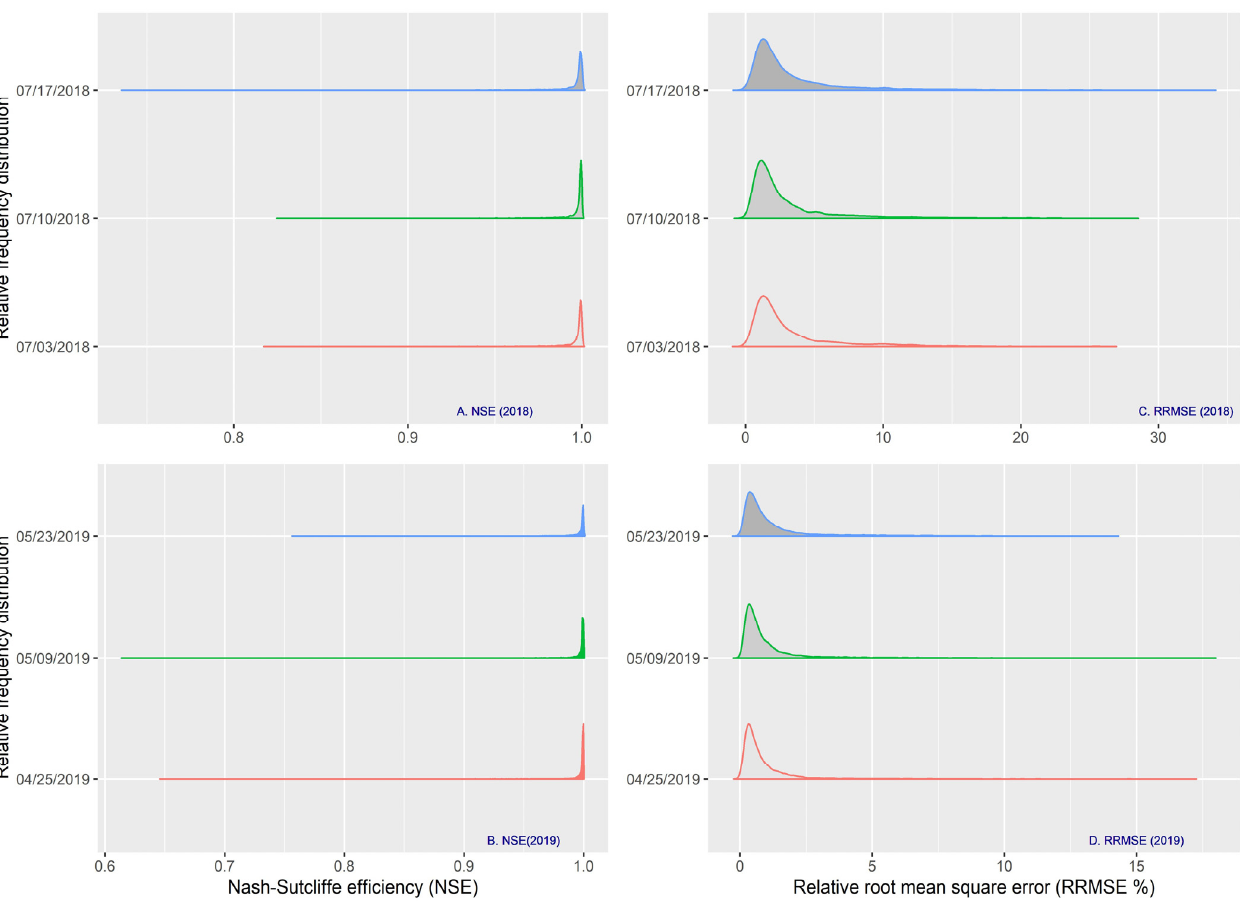
Figure 2. Distribution of Nash–Sutcliffe efficiency (NSE) and relative root mean square error (RRMSE %) for Bezier curve fitting of rice leaf shapes for three planting dates. ( A ) NSE in 2018; ( B ) NSE in 2019; ( C ) RRMSE in 2018; ( D ) RRMSE in 2019. RRMSE: Relative root mean square error.